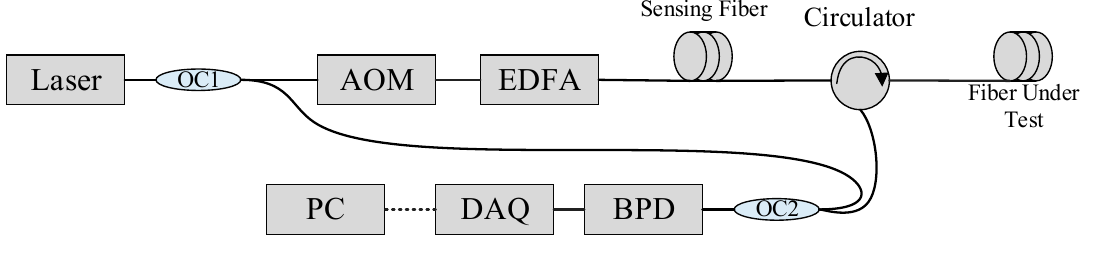
Figure 1. Heterodyne coherent detection structure.